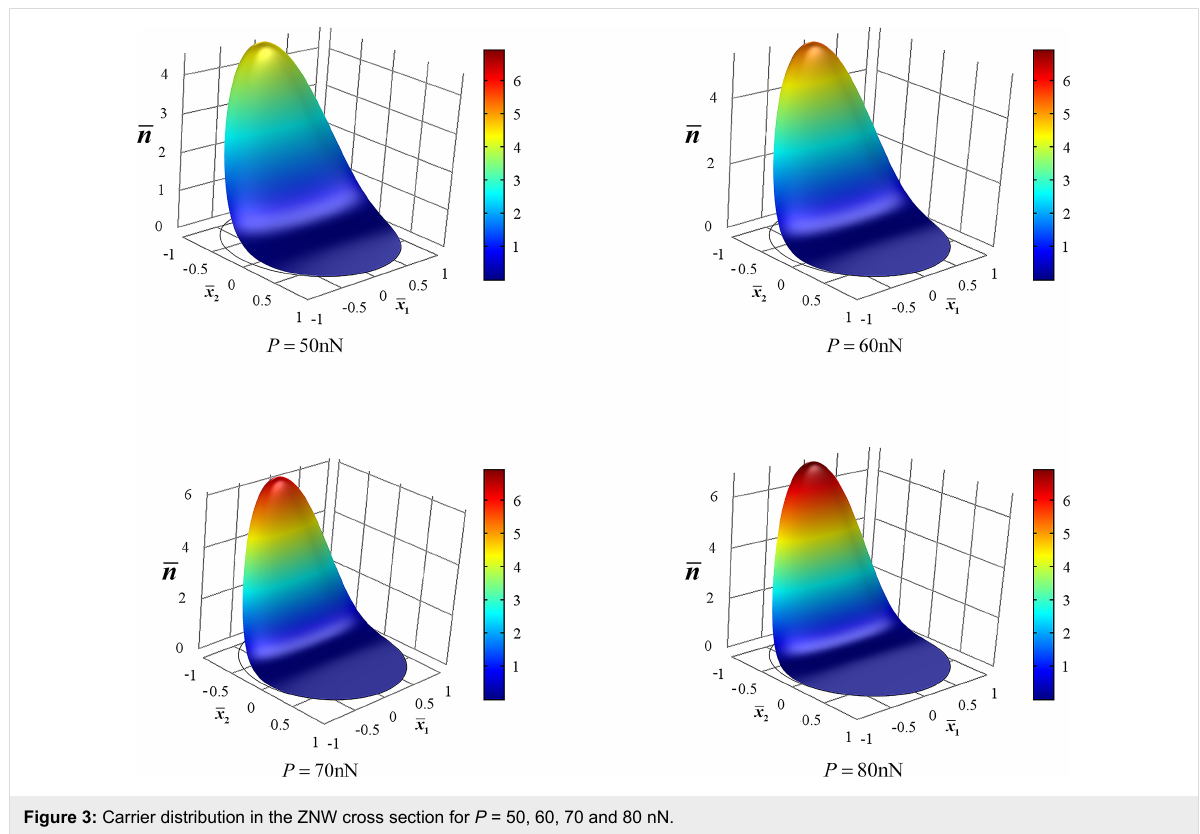
Figure 3: Carrier distribution in the ZNW cross section for P = 50, 60, 70 and 80 nN.